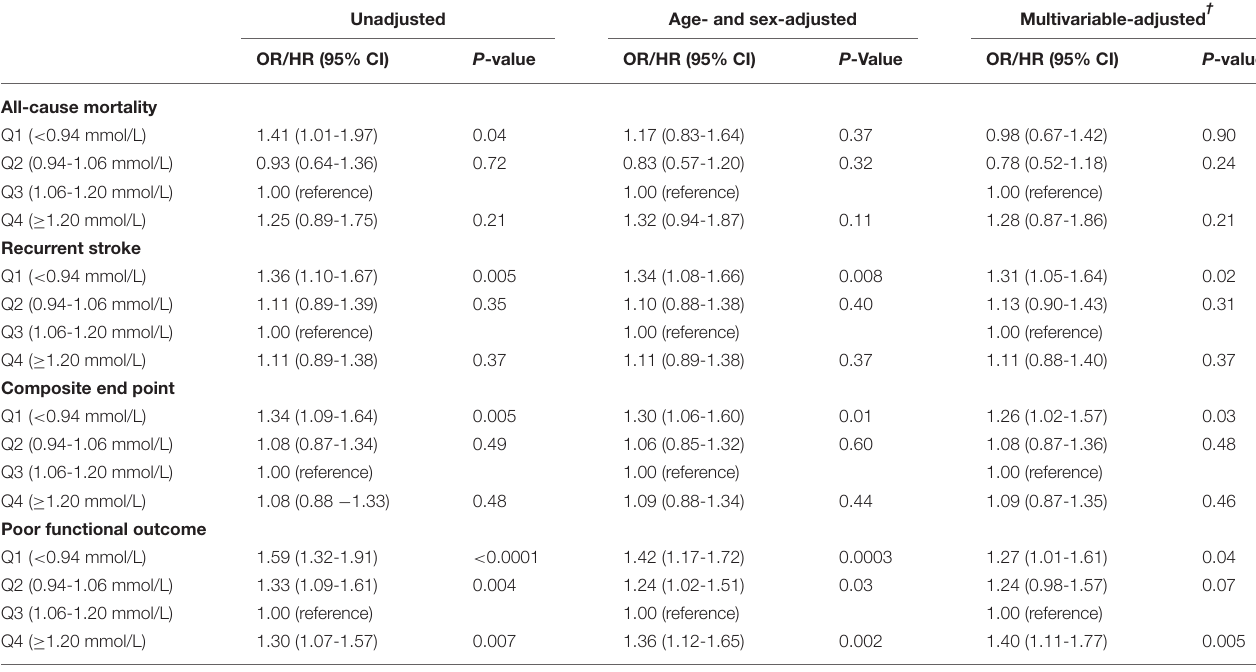
TABLE 3 | Association between serum phosphate level and clinical outcomes. Unadjusted Age- and sex-adjusted Multivariable-adjusted